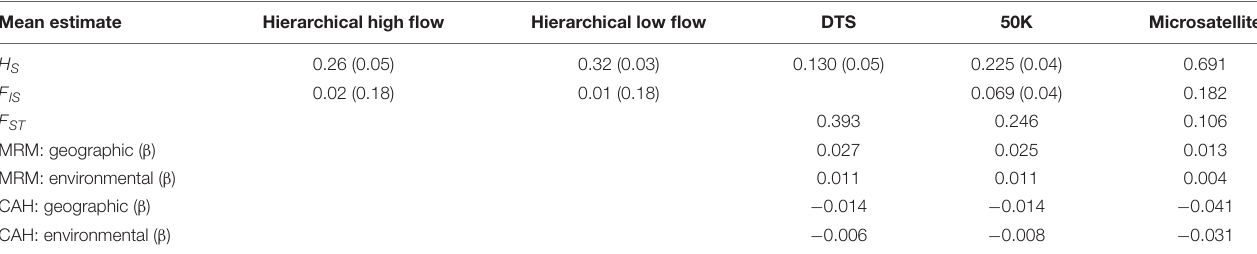
TABLE 2 | Summary statistics estimated for the DTS, 50K, and microsatellite datasets of Mexican wild maize. Mean